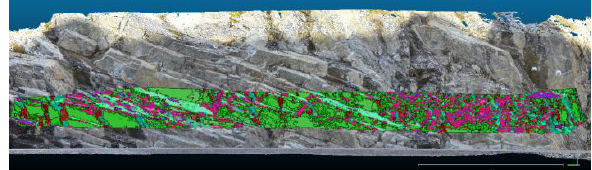
Figure 3. Facets extracted around the scanline. Colours depict normal with HSV convention (Hue assigned to dip direction).